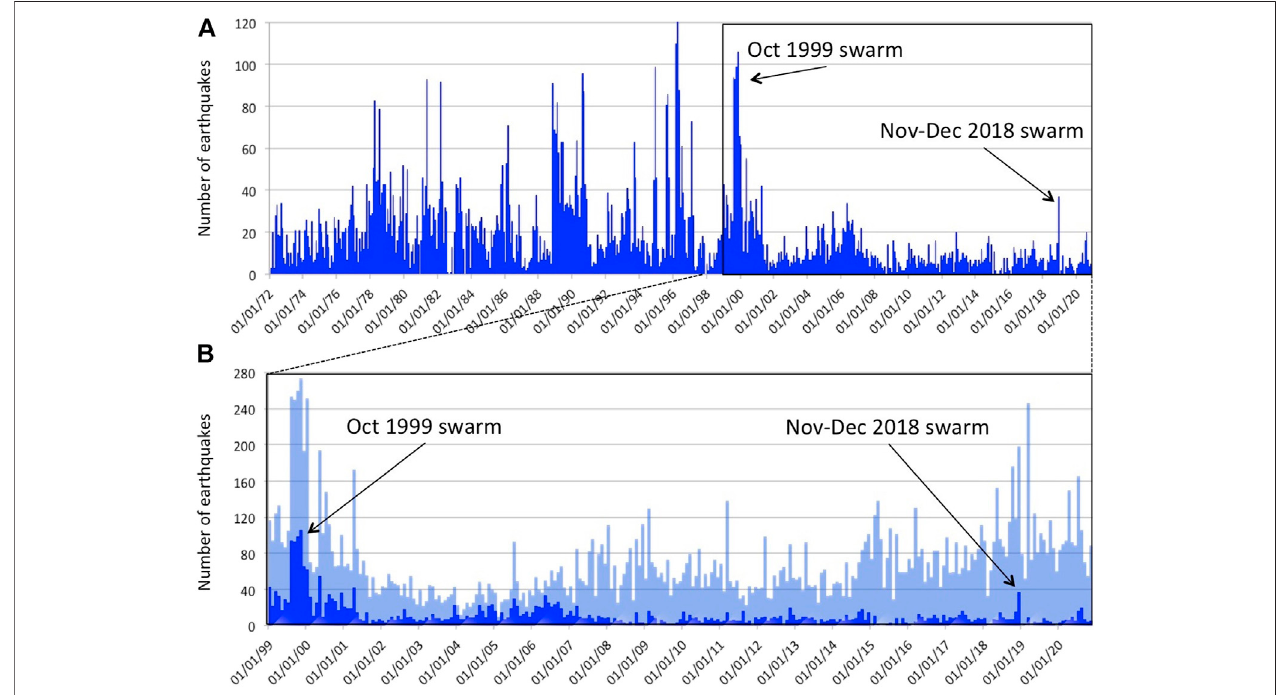
FIGURE 8 | (A) Number of earthquakes per month detected by the OVO station from 1972 to December 31, 2020. (B) Comparison between the number of earthquakes per month detected by the OVO station (blue) and the BKE station (light blue) from 1999 to 2020 (November 30). The catalogs are included in the supplementary Datasheet S1